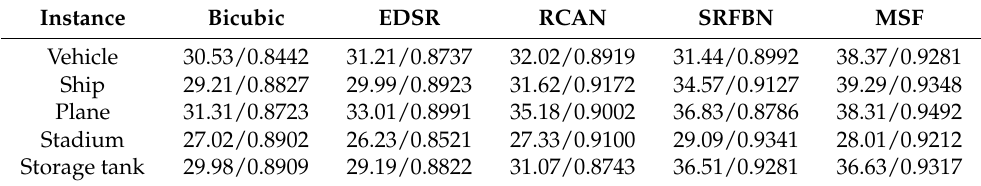
Table 1. The average PSNR/SSIM results of SR models on five categories of instances with a new randomly generated Gaussian blur kernel (scaling factor 2).